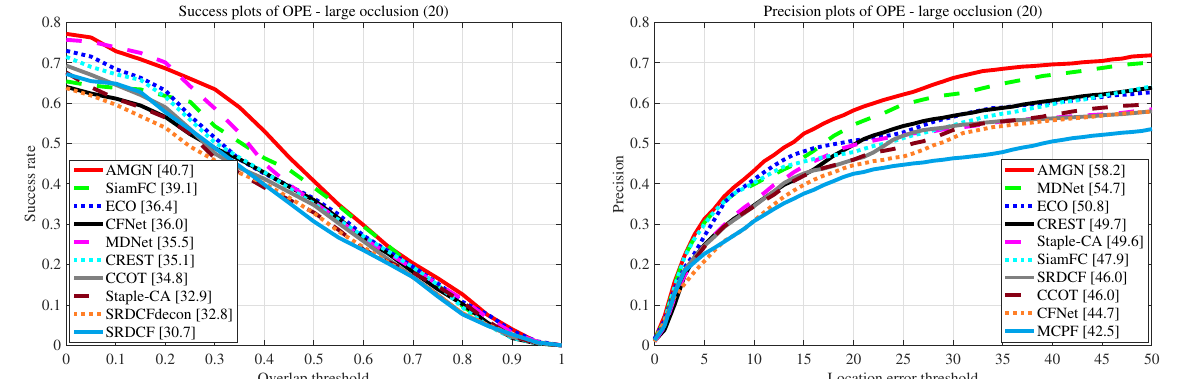
Figure 10. Success and precision plots on the UAVDT dataset using one-pass evaluation over tracking challenge large occlusion.